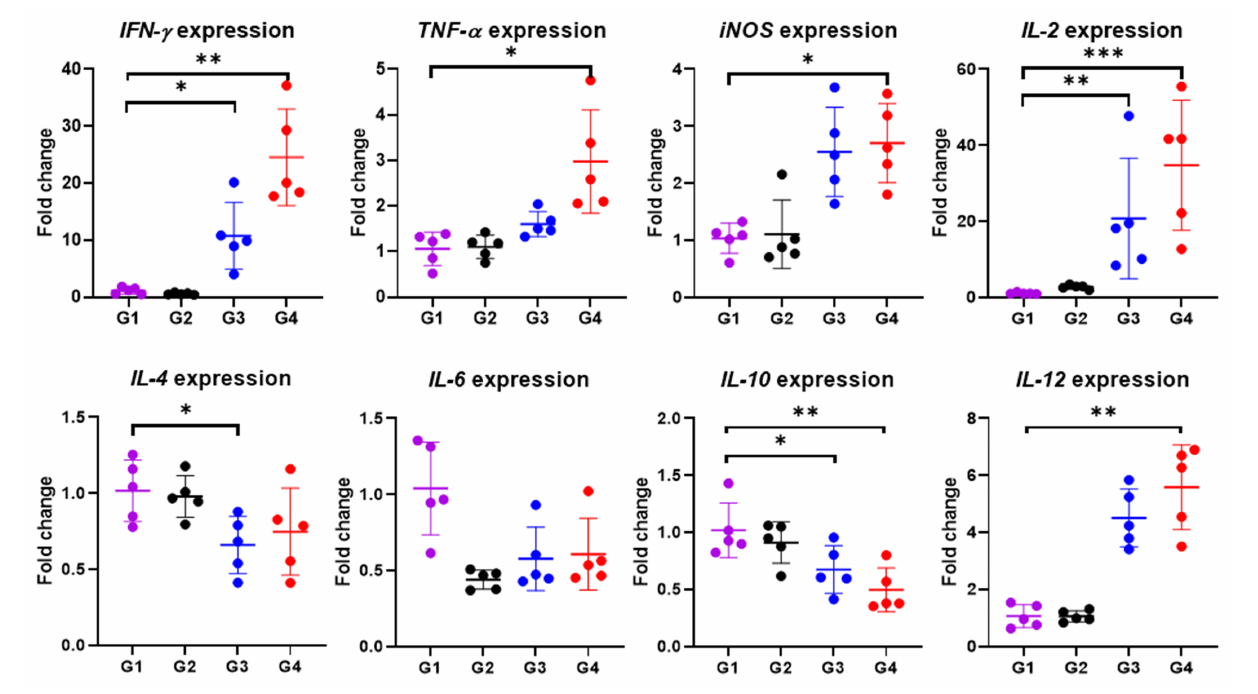
FIGURE 5 | Inflammatory cytokine gene expression profiles induced by rBbAMA-1(I/II). The results are expressed as mean values ± SD. Asterisks indicate a significant difference (* < 0.05; ** < 0.01; *** < 0.001). Experimental groups G1 = non-immunization, G2 = Montanide ISA 206 VG + PBS, G3 = rBbAMA-1(I/II) 50 µ g + Montanide ISA 206 VG and G4 = rBbAMA-1(I/II) 100 µ g + Montanide ISA 206